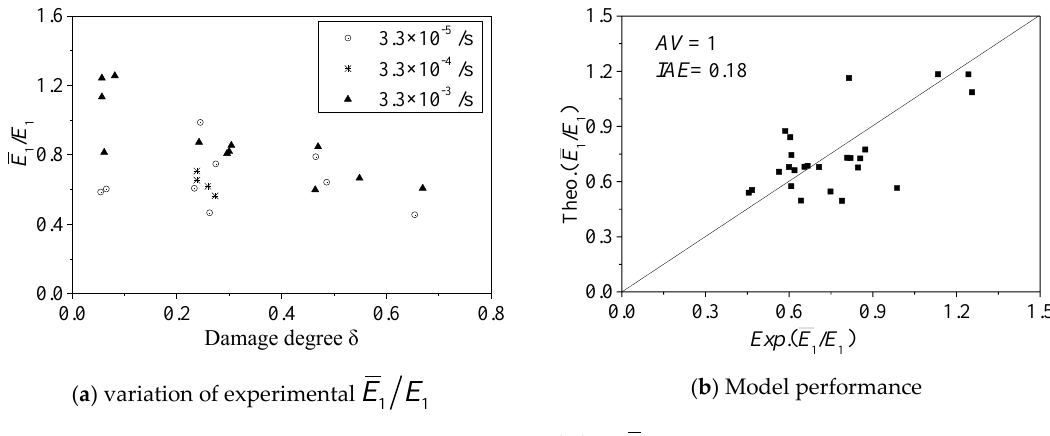
Figure 9. Initial slope E 1 .